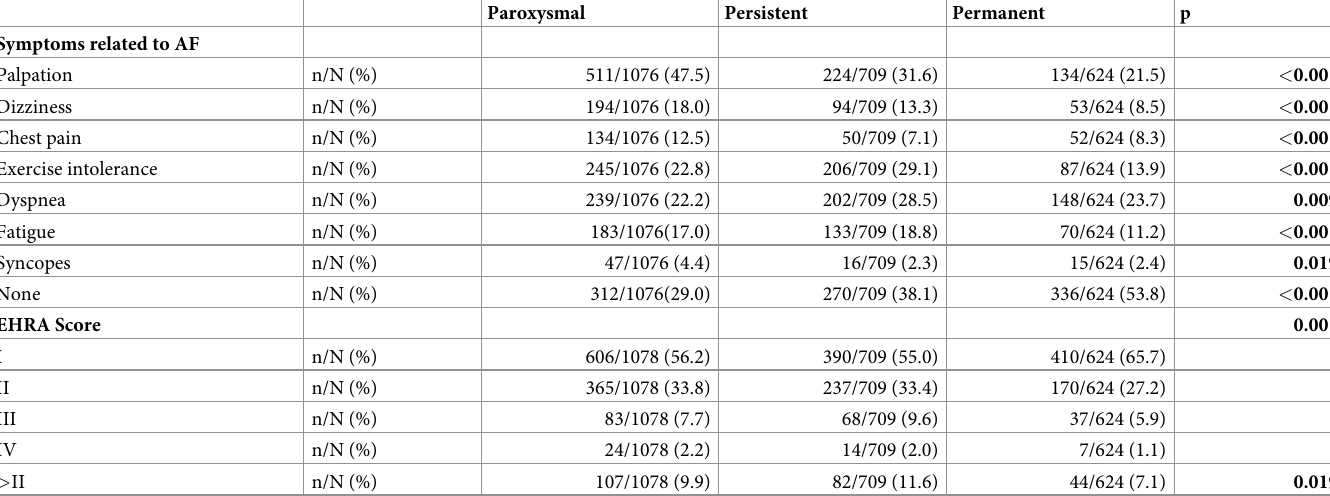
Table 2. Symptoms and EHRA Score according to AF type. EHRA, European Heart Rhythm Association.